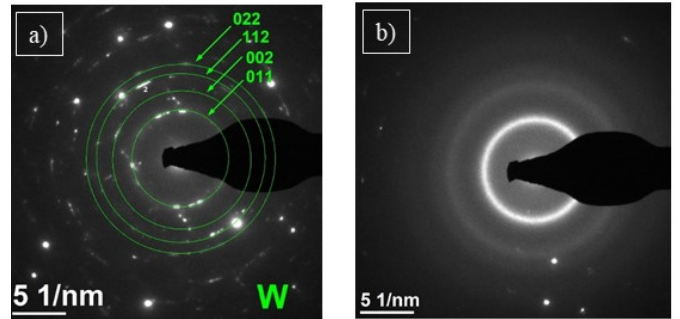
Figure 11. The SAED electron diffraction of sample C2, performed for the area marked as B ( a ) and amorphous matrix ( b ).